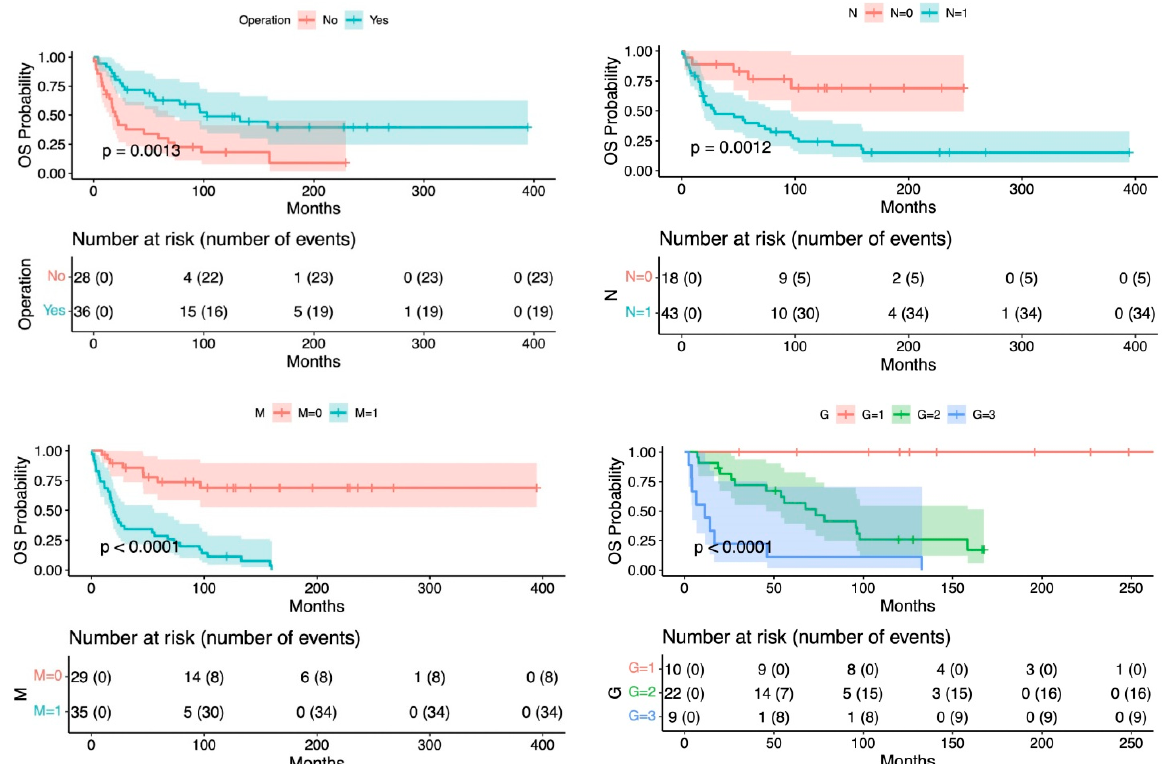
Figure 1. Overall survival related to surgical operation, lymph node metastases, distant metastases, and tumor grade.